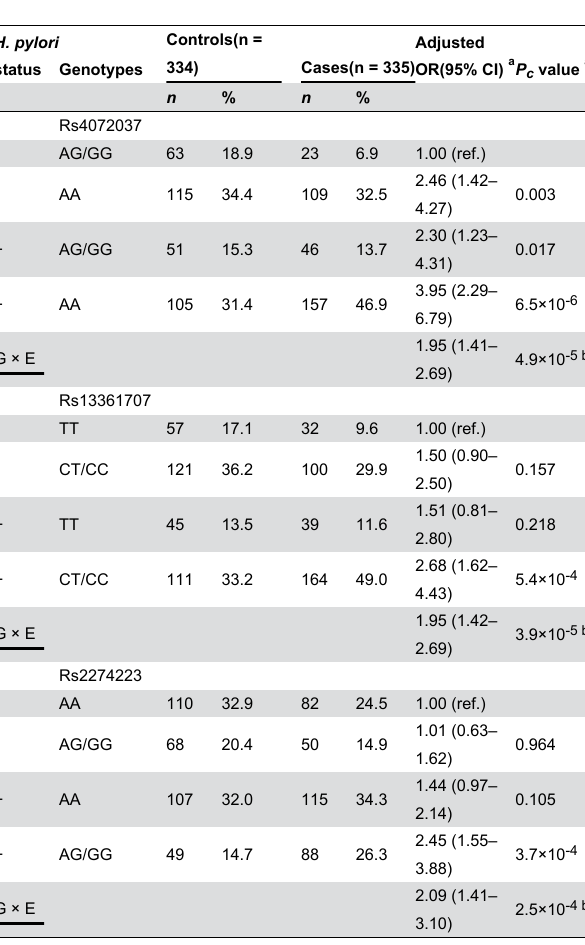
Table 2. Distribution of genotypes and alleles of the three SNPs (rs4072037, rs13361707 and rs2274223) and their association with GC risk.